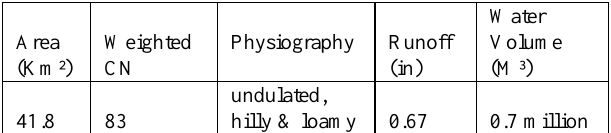
Figure 6. TRMM and gauged runoff variation A sub-catchment of Wadi El Hawad catchment was investigated and assessed to evaluate runoff and water harvest potential. The sub-catchment characteristics were shown in below (Table 4 and Figure 7).